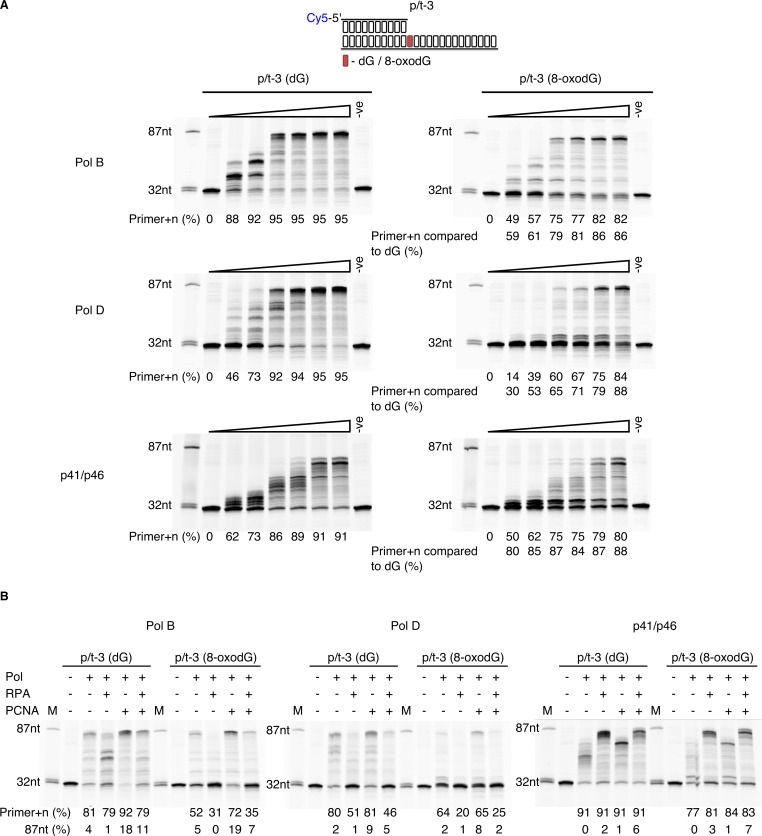
Primer extension under ‘standing start’ reaction conditions.(A) Replicative enzyme activity when polymerisation is initiated from a pre-stalled start using p/t-3 containing either dG of 8-oxodG. The triangle above each gel image indicates time course of primer extension (time points taken at 0, 0.5, 1, 5, 10, 30 and 60 min). Primer+n compared to dG was calculated as formation of primer+n in 8-oxodG containing templates as a relative percentage of primer+n formation in dG containing templates. (B) Influence of RPA and PCNA on replicative enzyme activity when polymerisation is initiated from a pre-stalled start. Primer extension and translesion synthesis activity of PolB, PolD and the p41/p46 complex performed during a 15 min reaction.